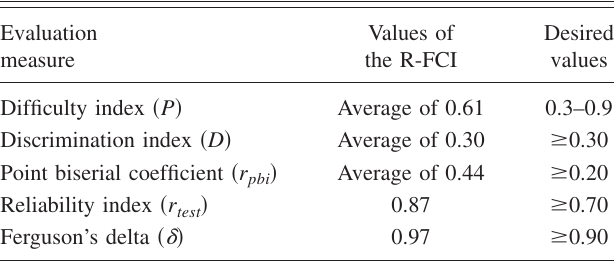
TABLE VII. Evaluation of the R-FCI.